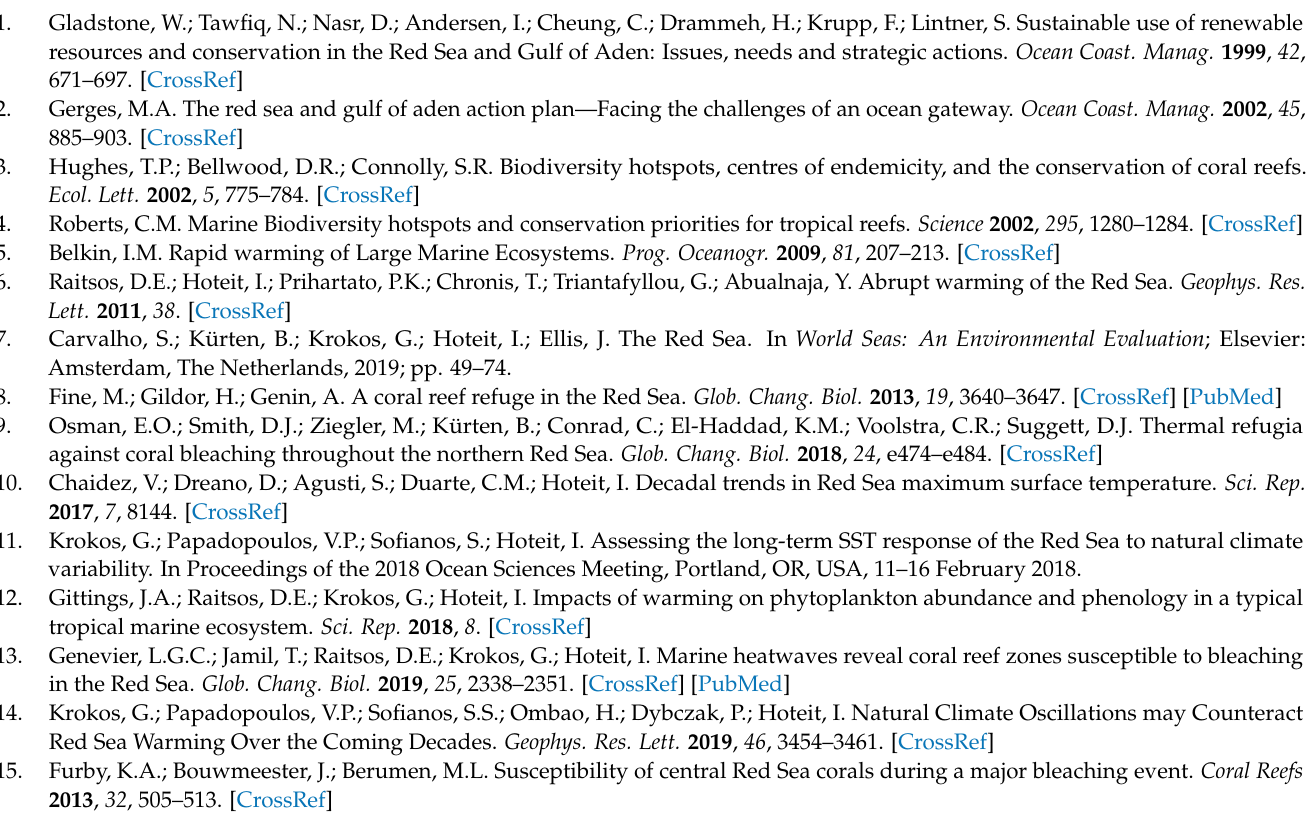
in situ observations, Figure S4: Mean MLD in NEOM during each season, Table S1: SST from in situ